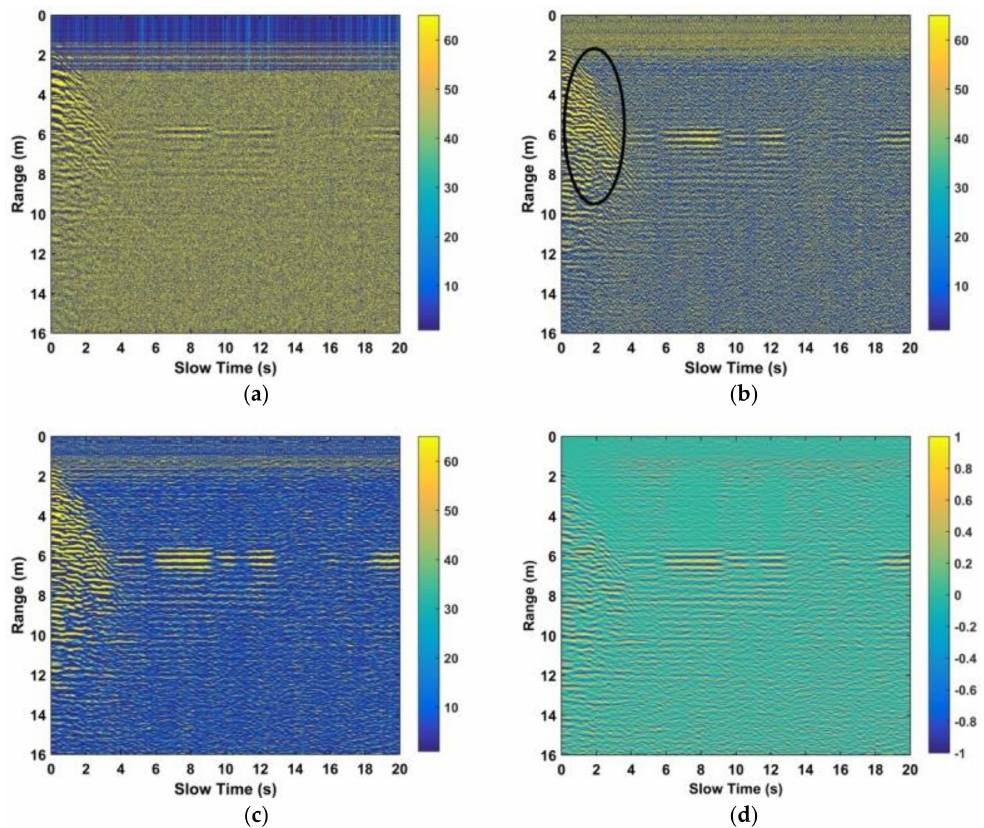
Figure 12. ( a ) Range results after removing the static and non-static clutter and the linear trend, ( b ) after filtering in fast time, ( c ) after filtering in slow time, and ( d ) after respiration signal improvement using the data acquired with the human subject stood behind the wall at 600 cm from the radar facing the